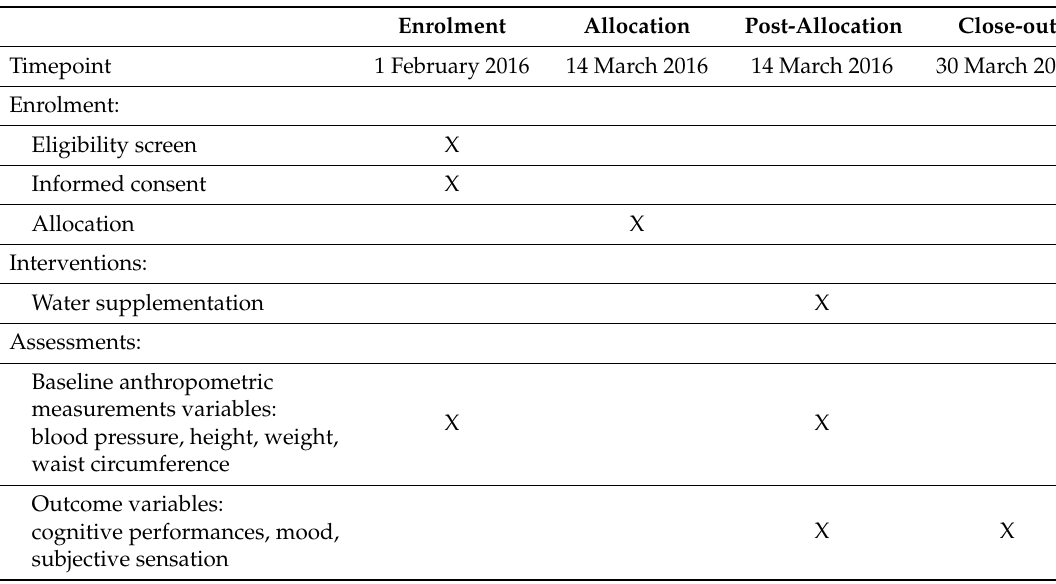
Table 2. The schedule of enrolment, interventions, and assessments.